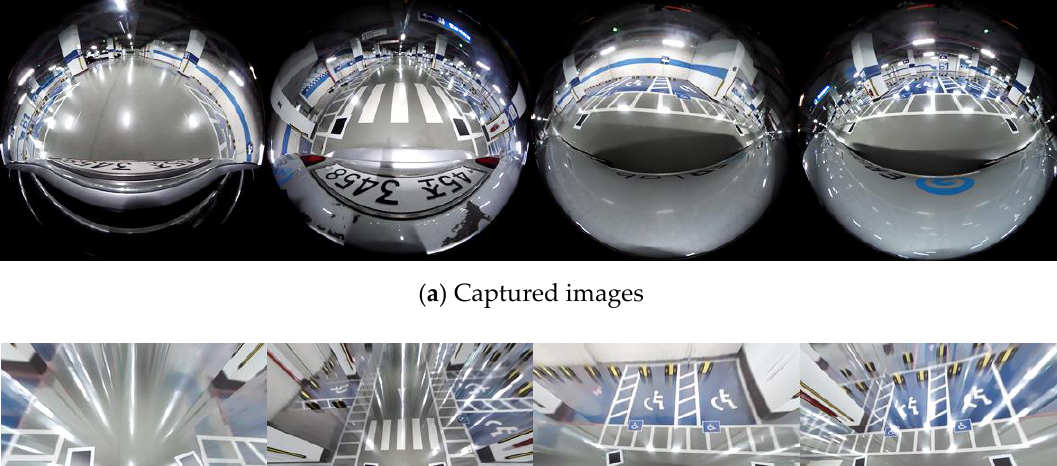
Figure 10. The experimental environment with four randomly placed calibration boards.